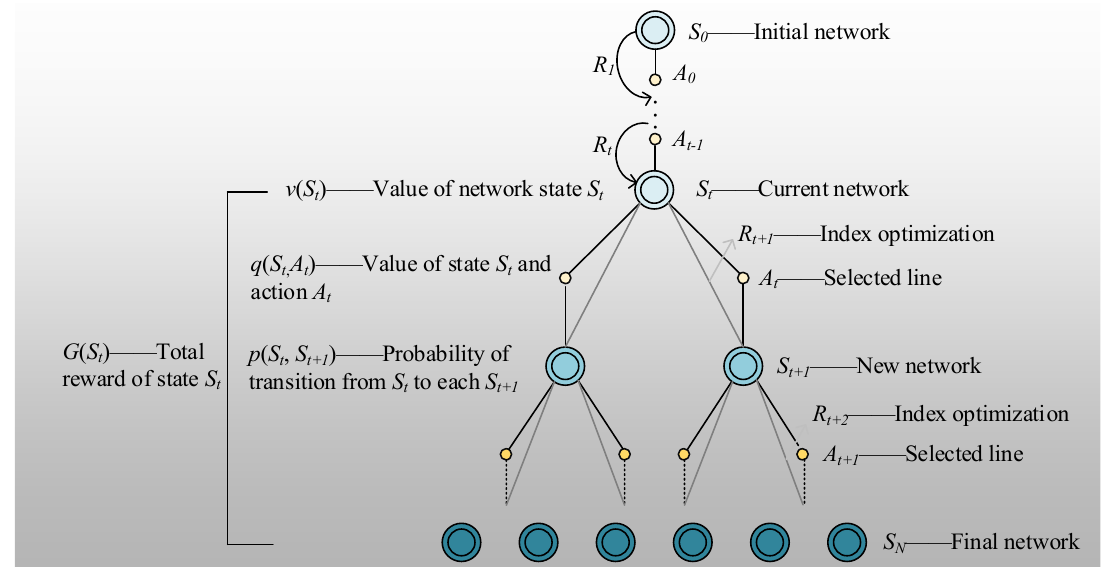
Figure 2. Schematic diagram of Markov Chain model for the TNEP task.